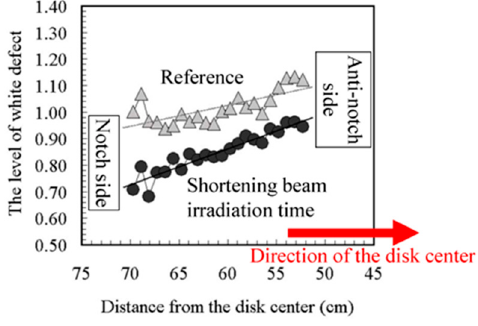
Figure 12. The white defect level variance on a wafer in a CCD image sensor [23].